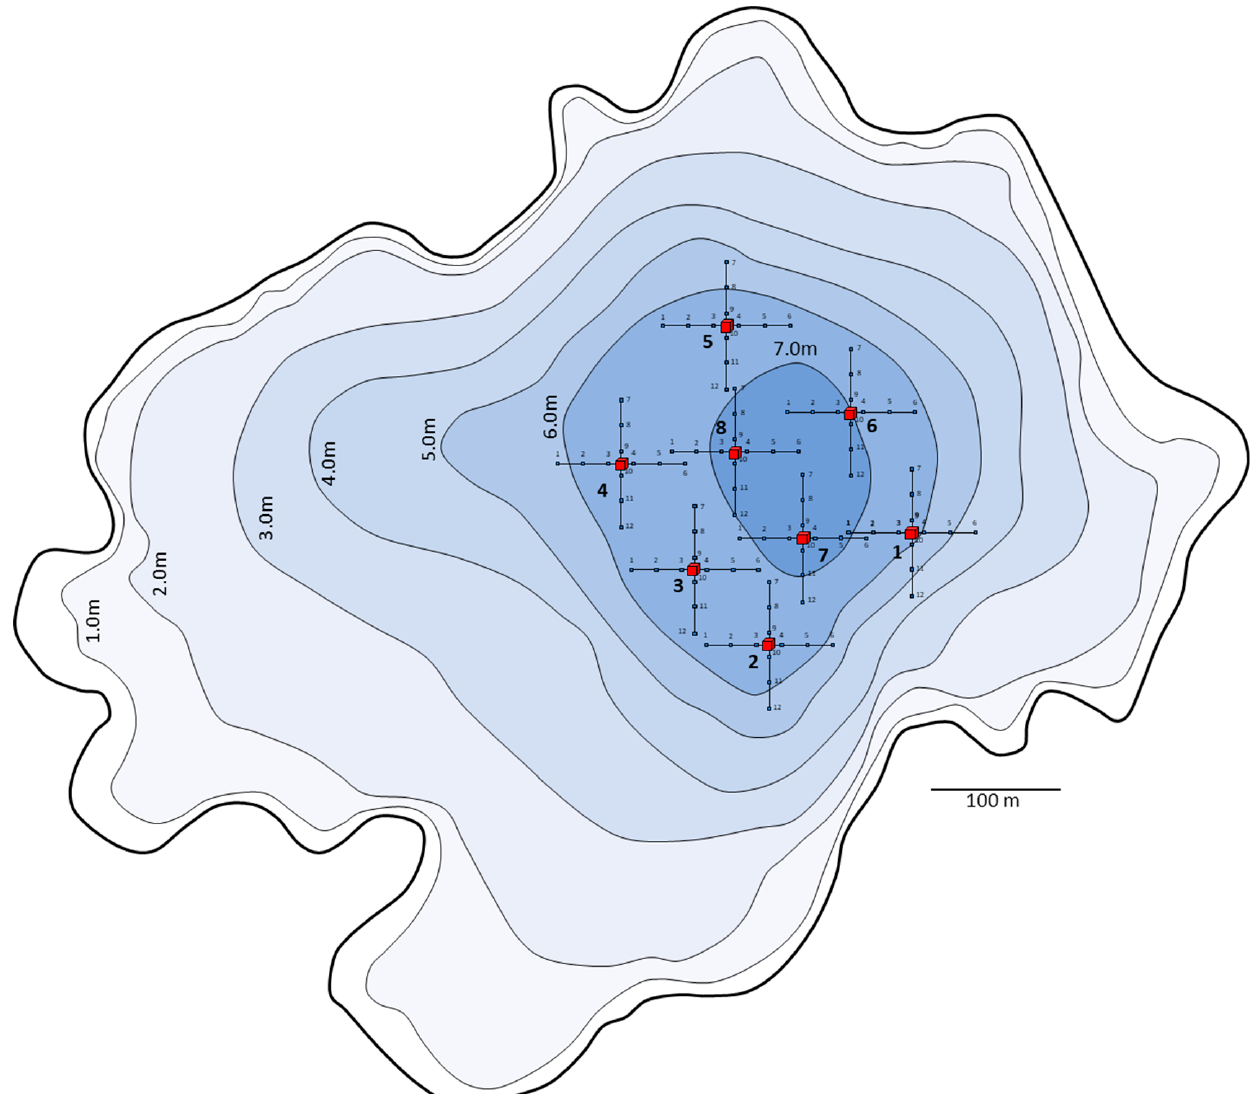
Figure 3. Bathymetry and layout scheme of measurement stations in Lake Ł ajskie.